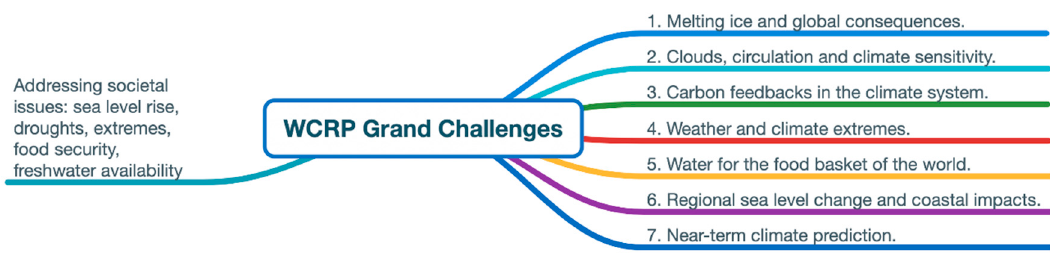
Figure 7. WCRP Grand Challenges (https://www.wcrp-climate.org/grand-challenges/grand-challenges-overview, last accessed 27 September 2019).